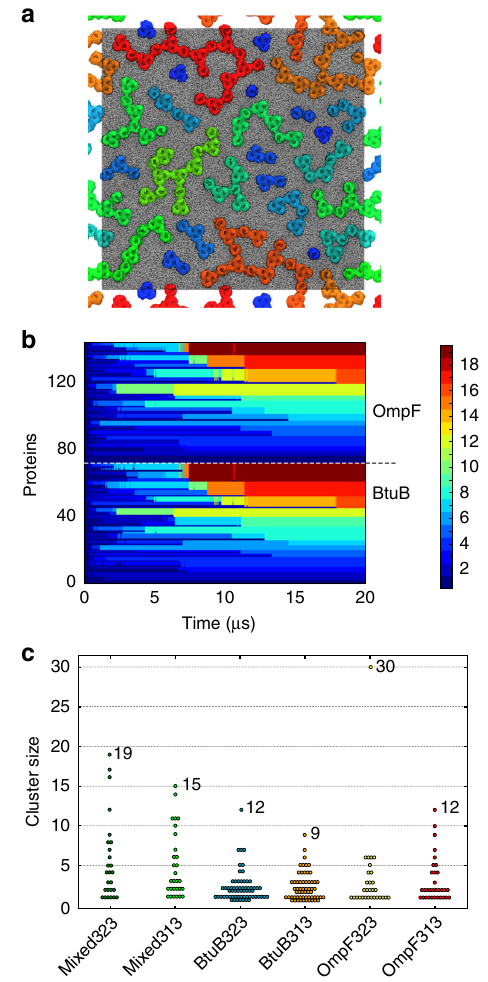
Fig. 2 Clustering of OMPs in simulations. a Nanoscale clustering of BtuB and OmpF (Mixed323 simulation — see Table 1) at 20 µ s. Proteins are coloured according to cluster membership on a blue (one of two molecules/cluster) to red (>16 molecules/cluster) scale. The colour scale, representing cluster size, is shown on the right side of the panel. b Evolution of cluster sizes over the course of the 20 µ s Mixed323 simulation. Each horizonal line represents an individual protein, which is coloured according to cluster size on the same scale as in a . c Distribution of cluster sizes (at 20 µ s) for all six simulations (see Table 1 for details, and Supplementary Figure 3 for snapshots and time evolution for all